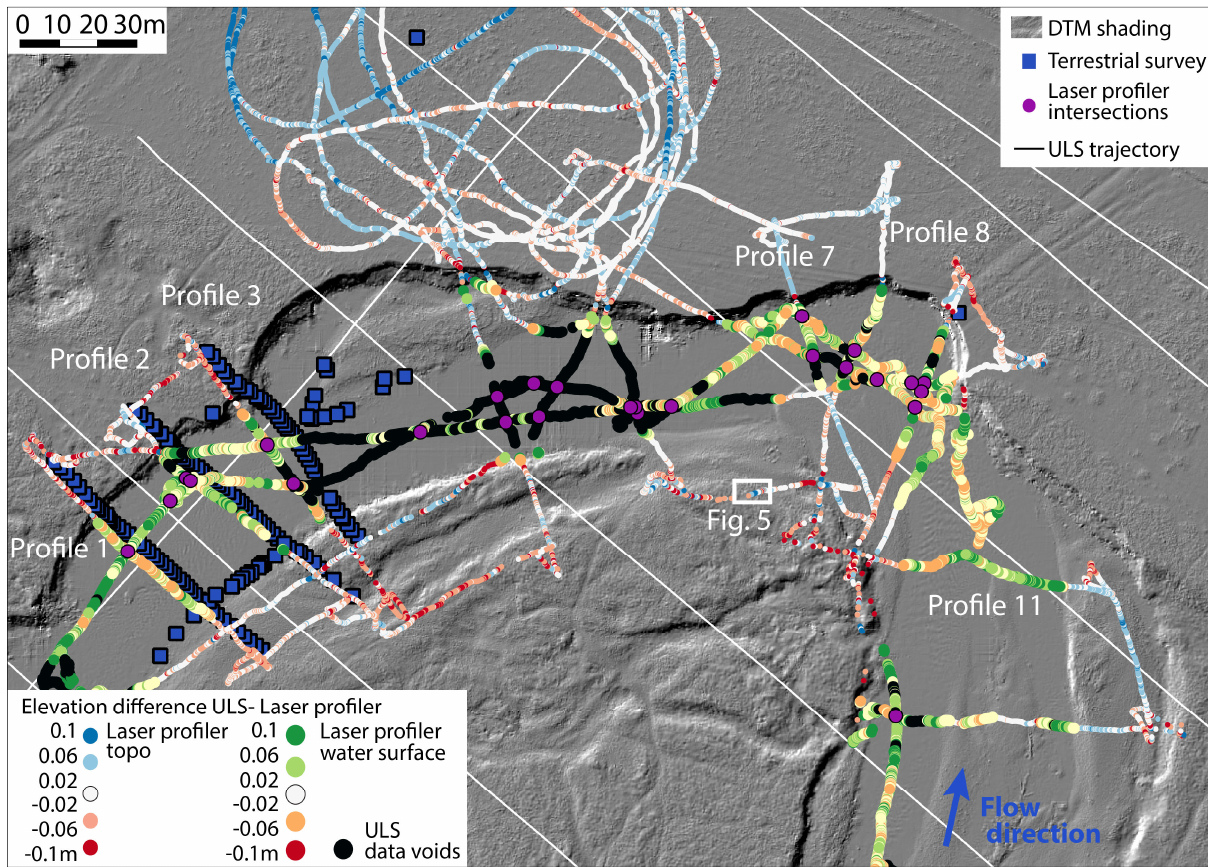
Figure 2. Study area Neubacher Au, background: hill shading, foreground: laser profiler echoes (coloured) and ULS flight path (white), locations of terrestrially surveyed cross sections